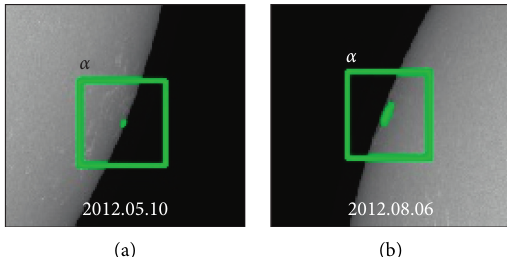
Figure 12: (a, b) Subregions at the edges of the solar surface observed at 20:00:00 UTon 10 May 2012 and at 20:00:00 UTon 6 August 2012, respectively.